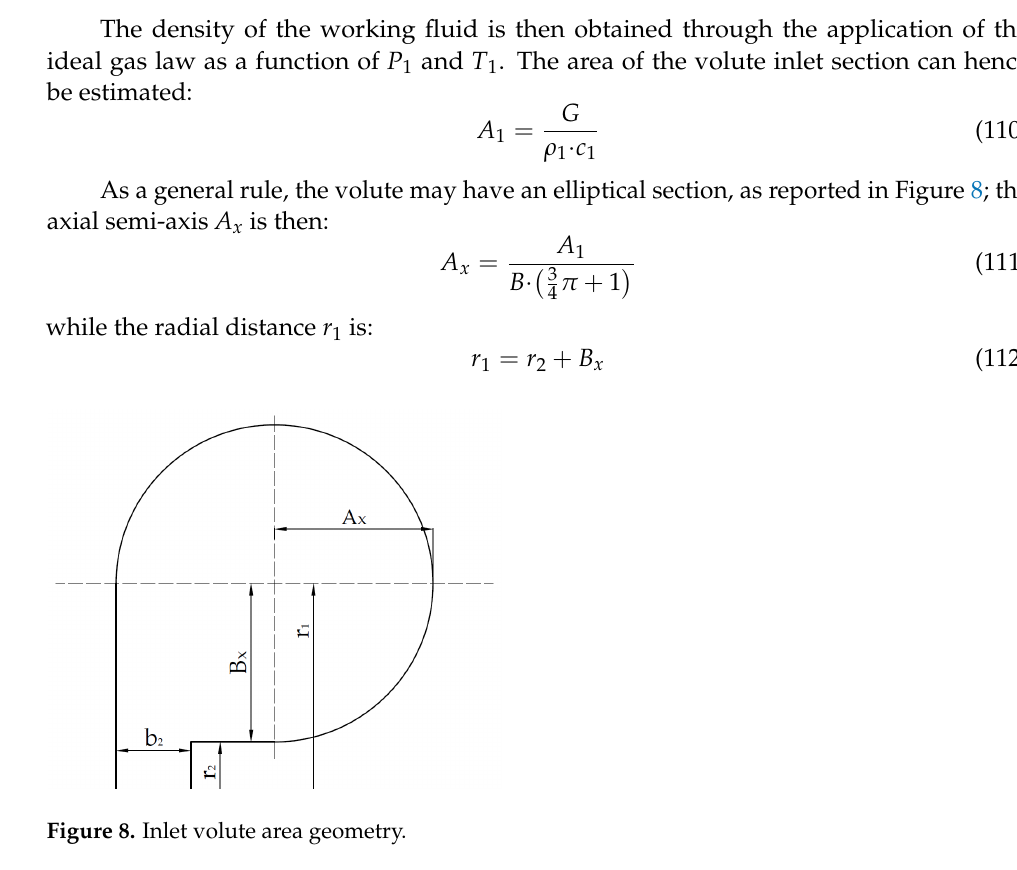
Figure 9. Flowchart of the design procedure adopted. 4. Conclusions The aim of this two-part work is a reliable evaluation of the realistic advantages connected to the implementation of a properly designed turbogenerator for exhaust en- Design algorithm First attempt estimation of the turbine efficiency η t,s Turbine performance prediction modelTurbine geometry output